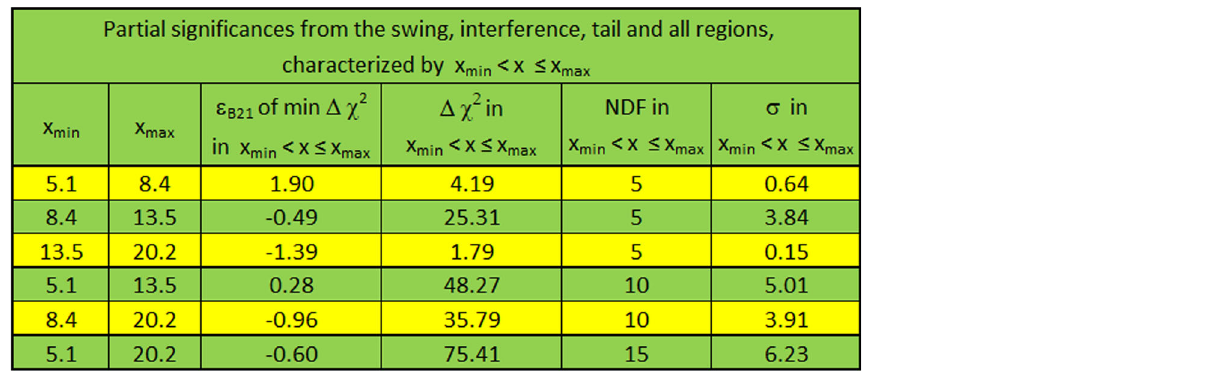
Table 12 Stability of the Odderon signal in various regions of x min tant to recognise, that the 10 D0 datapoints in the swing and diffractive interference region already provide a statistically significant, more than and x max , in the case, when the value of the correlation coefficient (cid:13) < x ≤ x 5 σ Odderon effect. The interference and the tail, taken together, also b , 21 locally minimized for the data in the x min max range. In indicate an Odderon signal, as a 3.91 σ , indicative but statistically this case, the greatest partial contribution to the Odderon significance comes from the diffractive interference (dip and bump) region with 8 . 4 ≤ x ≤ 13 . 5, the second most important contribution comes from the swing region, 5 . 1 < x ≤ 8 . 4, while the relatively least important contribution comes from the tail with 13 . 5 < x ≤ 20 . 2. It is impor-